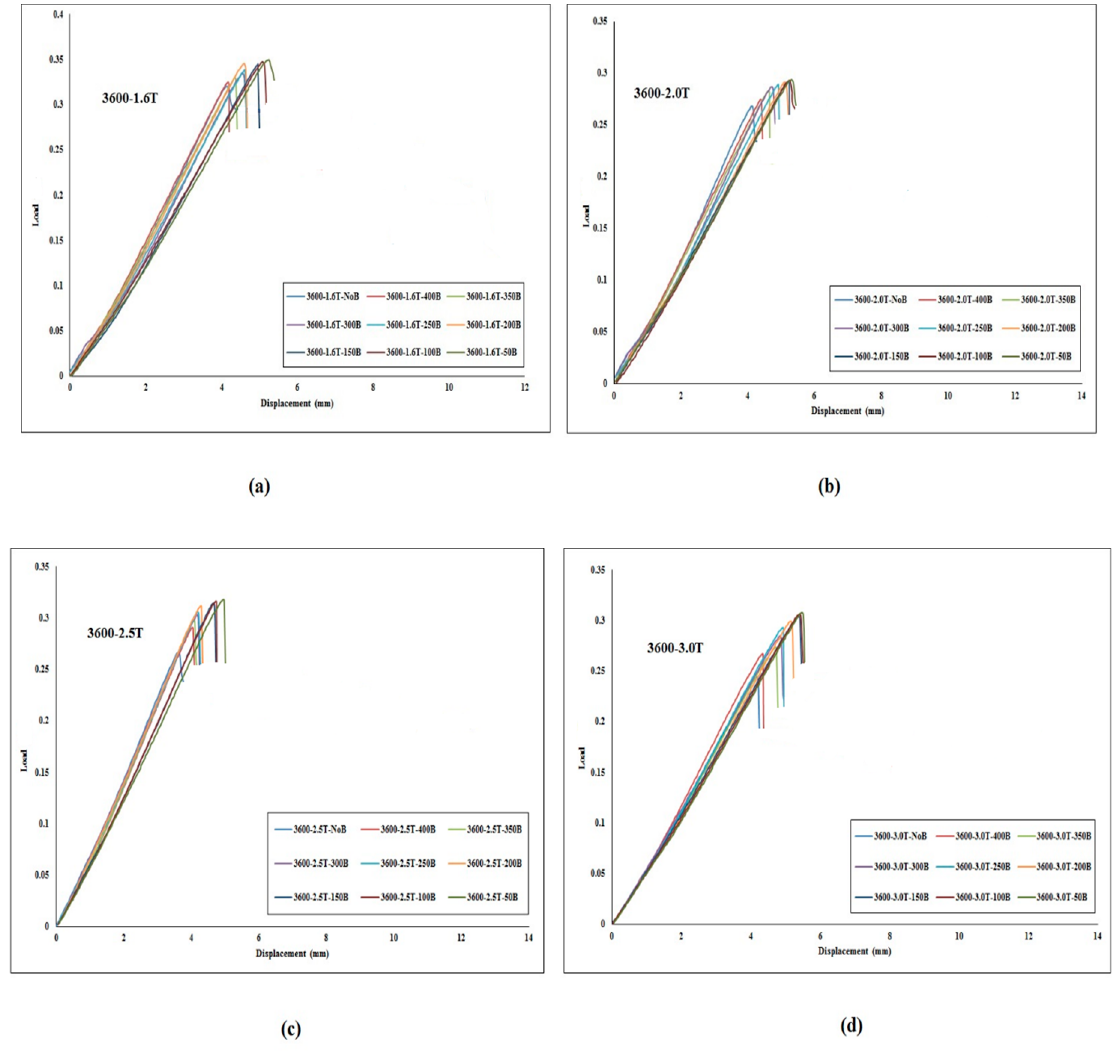
Figure 12. Normalised load-displacement diagrams of the FE results for: ( a ) 3600L-1.6T, ( b ) 3600L-2.0T, ( c ) 3600L-2.5T, and ( d ) 3600L-3.0T